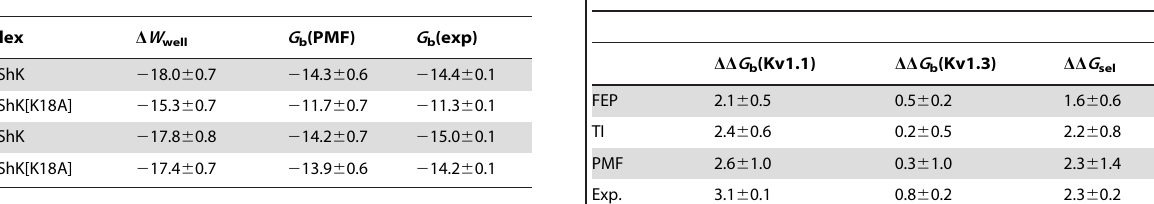
Table 4. Comparison of the binding free energy differences for Kv1.1 and Kv1.3, and the selectivity free energy for Kv1.3/ Kv1.1, obtained using the FEP, TI and PMF methods, with the experimental